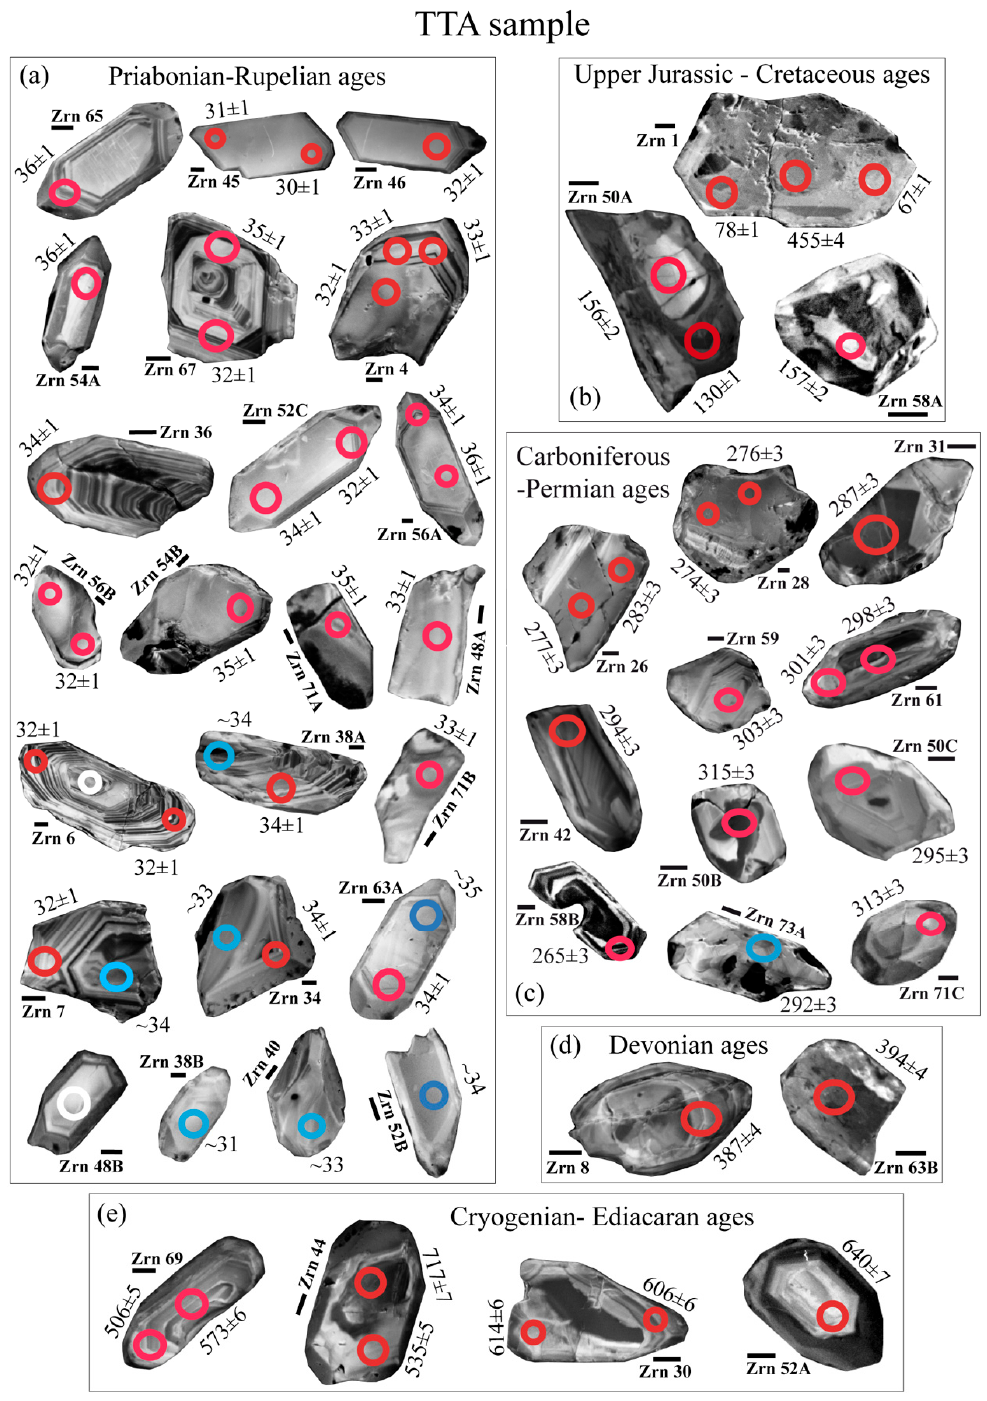
Figure 6. Variable pressure secondary electron (VPSE) images of the dated zircons in the TTA sample with spot locations and measured ages in millions of years (Ma). Red and blue circles indicate the spot location of the 206 Pb/ 238 U ages with % U-Pb discordance <±10% and those between 10% and 20%, respectively. White circles indicate the discordant ages. ( a ) Priabonian–Rupelian magmatic zircons; ( b ) Cretaceous ages at the rims of zrn1 with an Ordovician core and at the rim of zrn50A grain; Upper Jurassic ages at cores of zrn50A and zrn58A grains; ( c ) Carboniferous–Permian ages; ( d ) Devonian ages; ( e ) Cryogenian–Ediacaran ages. The notches near the crystal label refer 20 μ m.